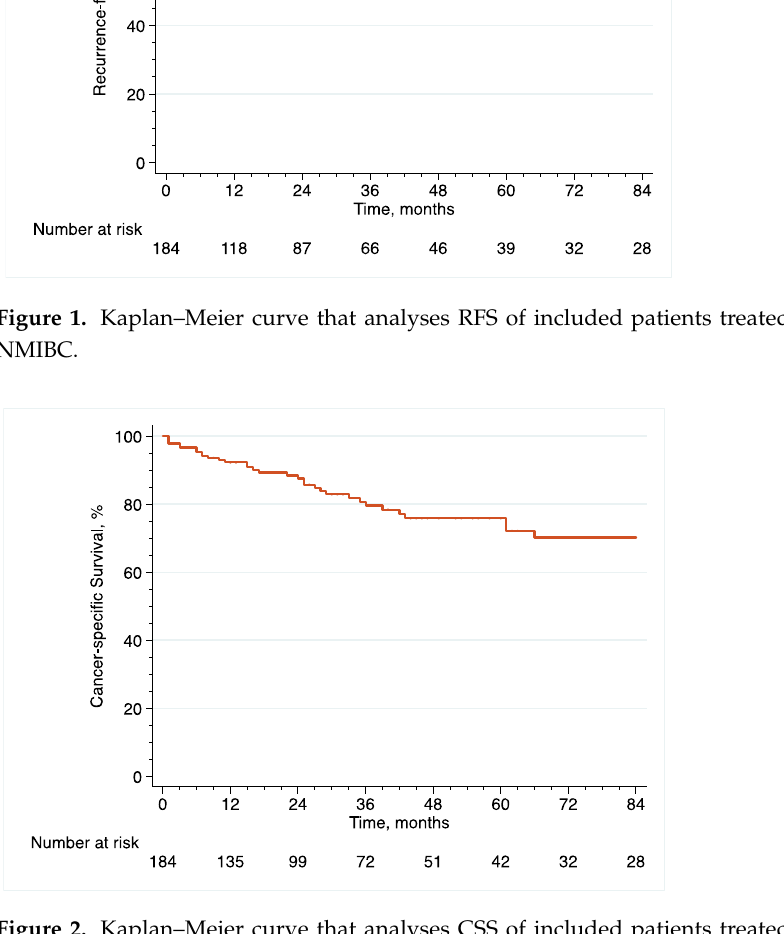
Figure 3. Kaplan–Meier curve that analyses the OS of included patients treated with eRC for HR- NMIBC.